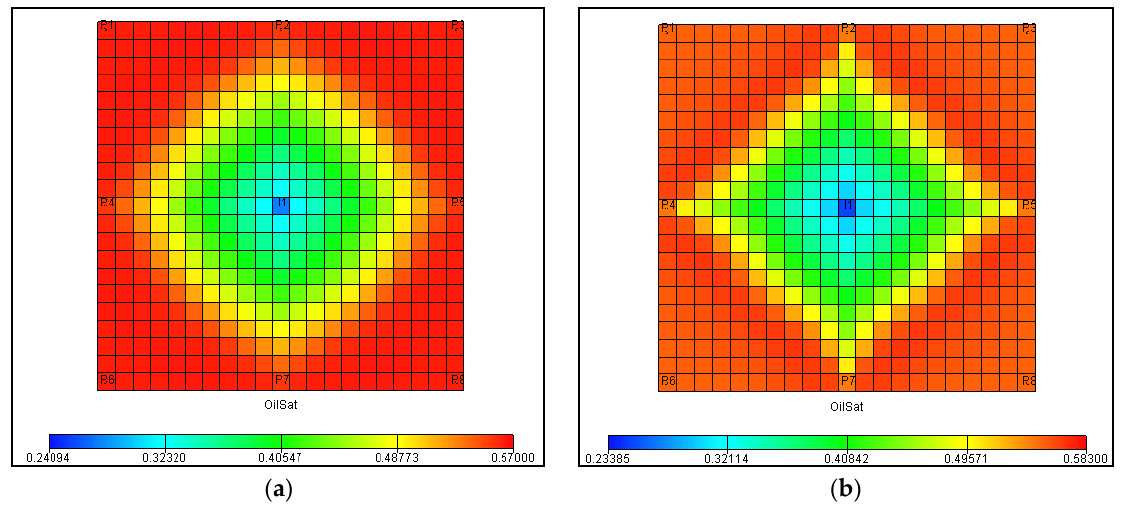
Figure 8. Residual oil saturation diagram on June: ( a ) Darcy seepage; ( b ) non-Darcy seepage.